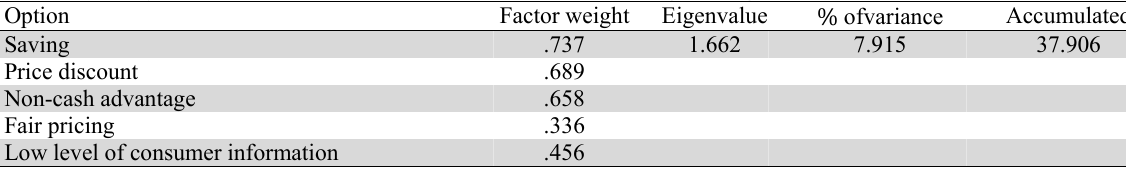
The summary of factors associated with consumer advantage margin